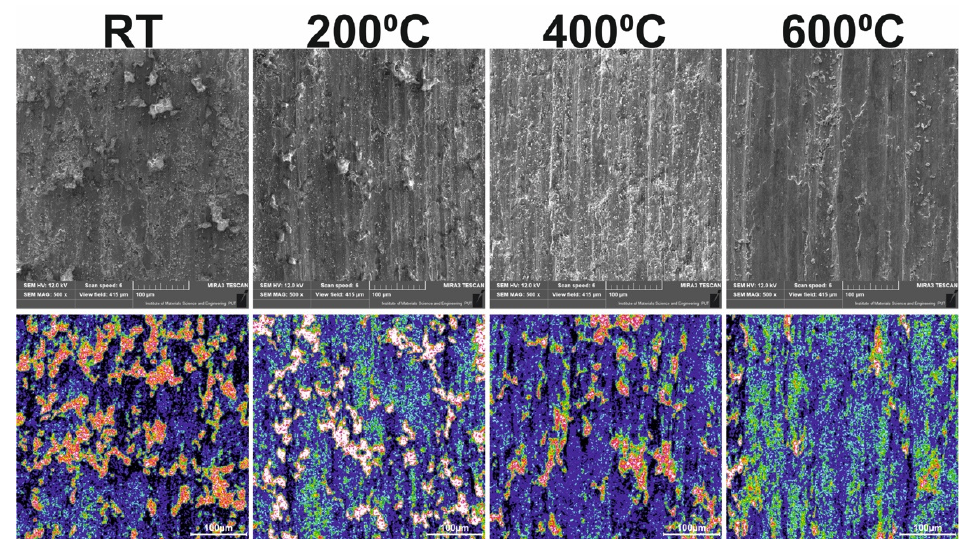
Figure 18. SEM and EDS images of the calcium concentration on the surface of the samples tested at different temperatures.